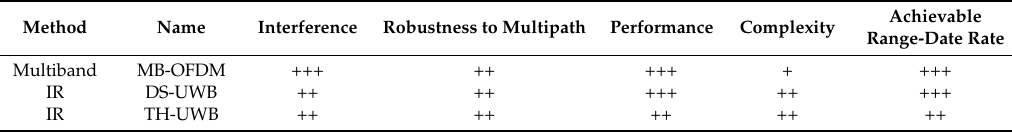
Table 2. Comparison summary of UWB